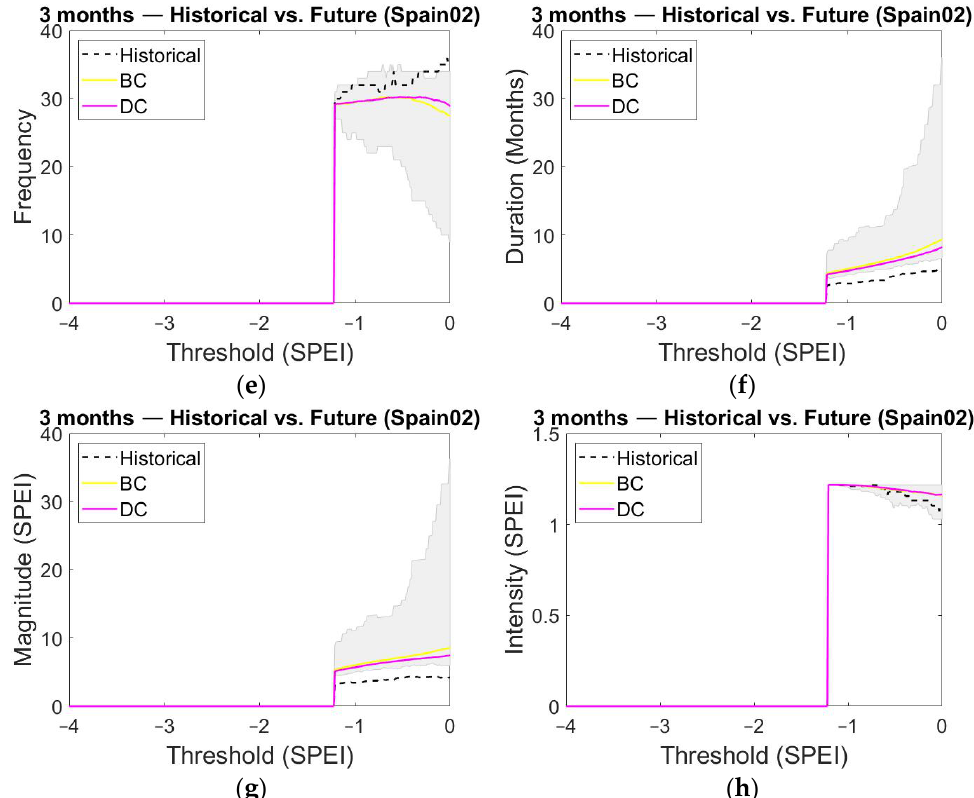
Figure 7. Historical and future meteorological drought ( a ) frequency; ( b ) mean duration; ( c ) mean magnitude; ( d ) mean intensity derived from SPI for the 3 months temporal-aggregation scale (Spain02 database). Historical and future meteorological drought ( e ) frequency; ( f ) mean duration; ( g ) mean magnitude; ( h ) mean intensity derived from SPEI for the 3 months temporal-aggregation scale (Spain02 database).